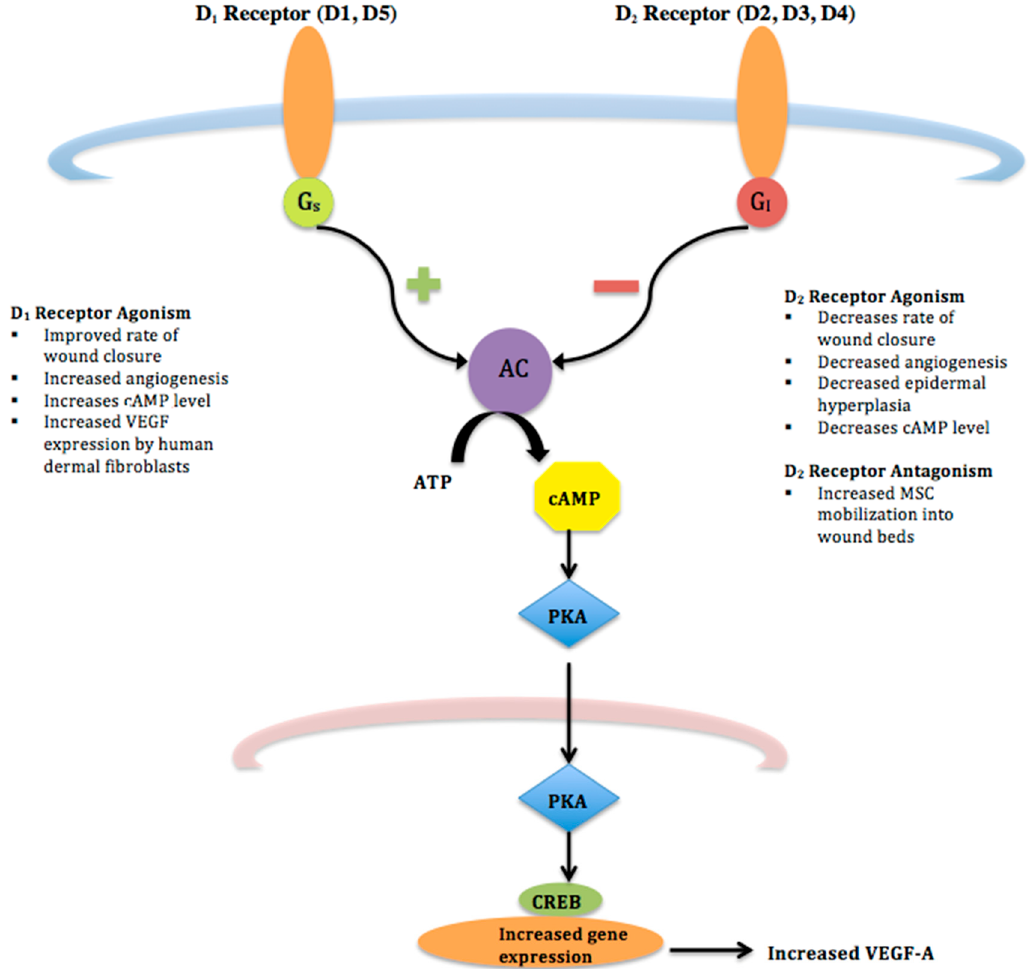
Figure 1. D 1 and D 2 Receptor Pathways – D 1 and D 2 receptors are G-protein coupled receptors that signal through different cascades. D 1 receptor agonists lead to increased production of adenylyl cyclase (AC) via a G s pathway. Conversely, agonism of D 2 receptors stimulates G i proteins leading to decreased cAMP and inhibiting neuronal activity.